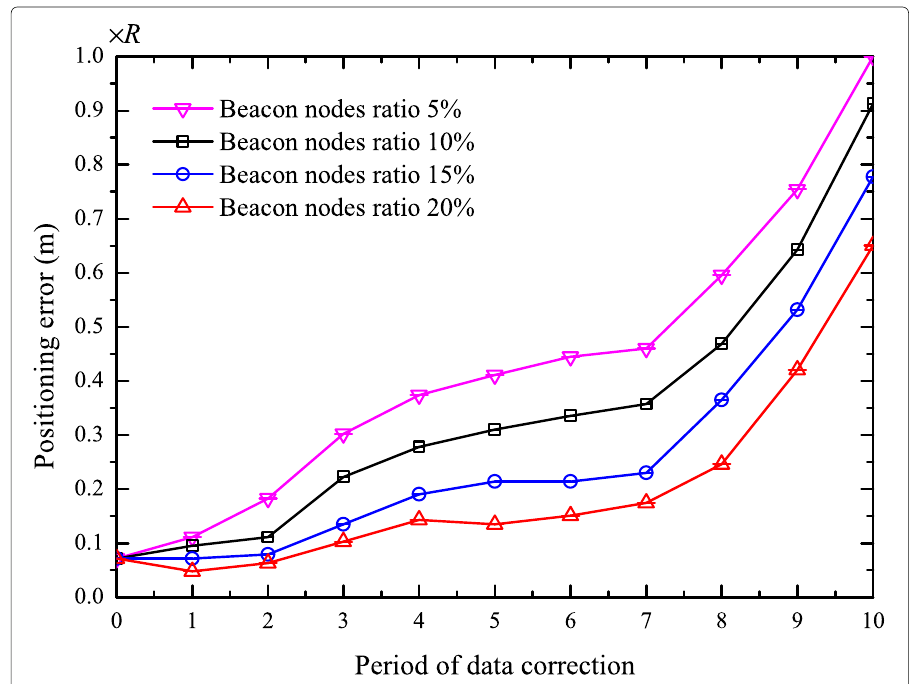
Fig. 9 Change of positioning error with the proportion of beacon nodes in 10 periods